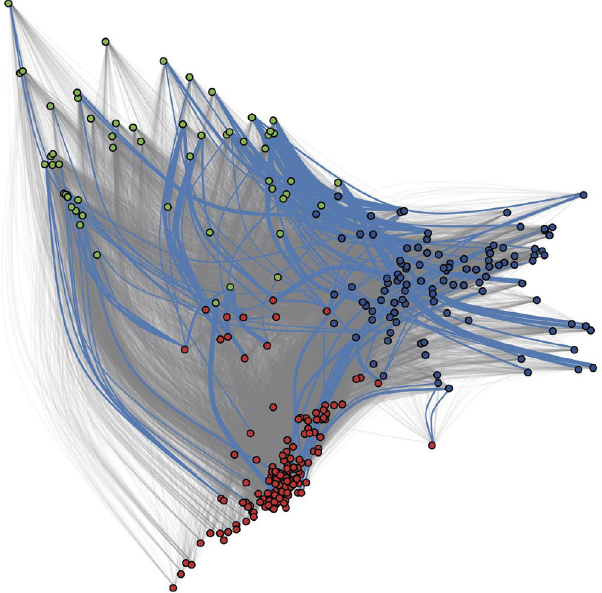
Figure 5. IBD sharing between the TS, NSS and SS populations. Red dots represent TS inbred lines, blue dots represent NSS inbred lines, and green dots indicate SS inbred lines. Edge width indicates the mean length of IBD tracts shared between one TS sample and one NSS/SS sample. The grey line connecting two samples indicatesthat the median length of IBD tracts is less than 7 cM (top 1%). A blue line connecting two samples indicates that the median length of IBD tracts is greater than 7